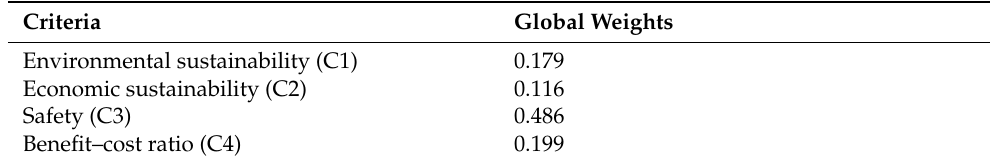
Table 3. Weights of criteria in order of